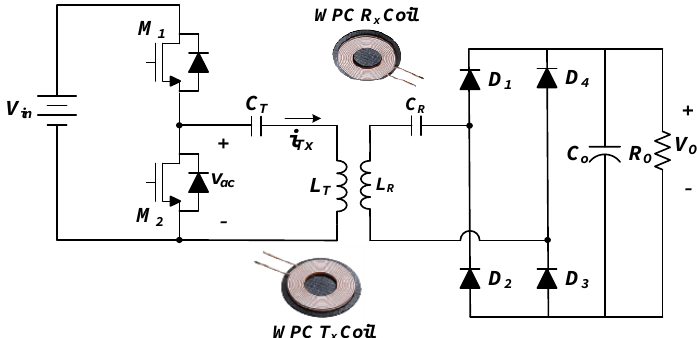
Figure 2. Wireless power consortium (WPC) LC series resonant circuit in the critical coupling condition.